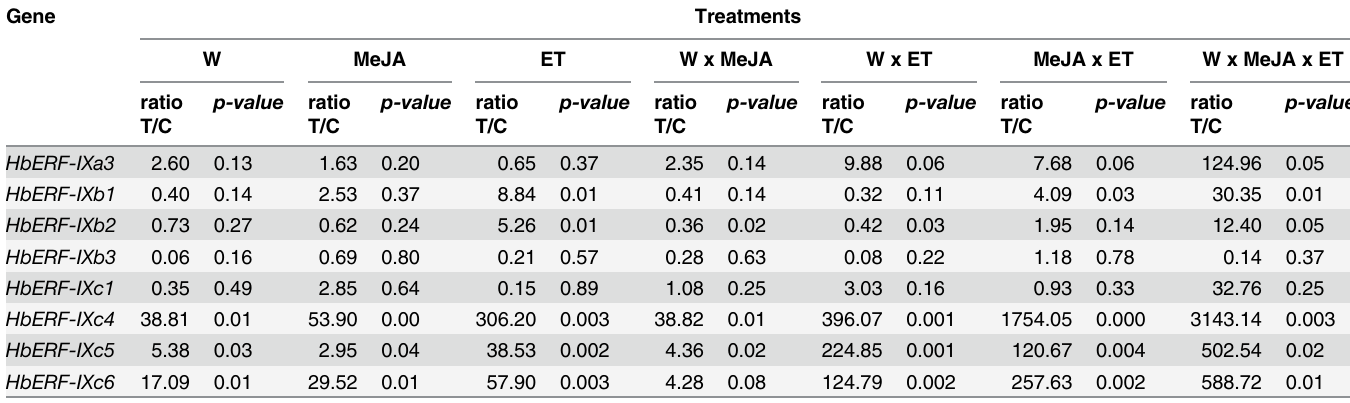
Table 3. Analysis of the relative transcript accumulation of 8 ERF genes of Hevea brasiliensis from group IX by real-time RT-PCR in the bark of the control (C) and plants subjected to seven different treatments: (W) wounding; (MeJA) methyl jasmonate; (ET) ethylene, either individually or in a combination of treatments